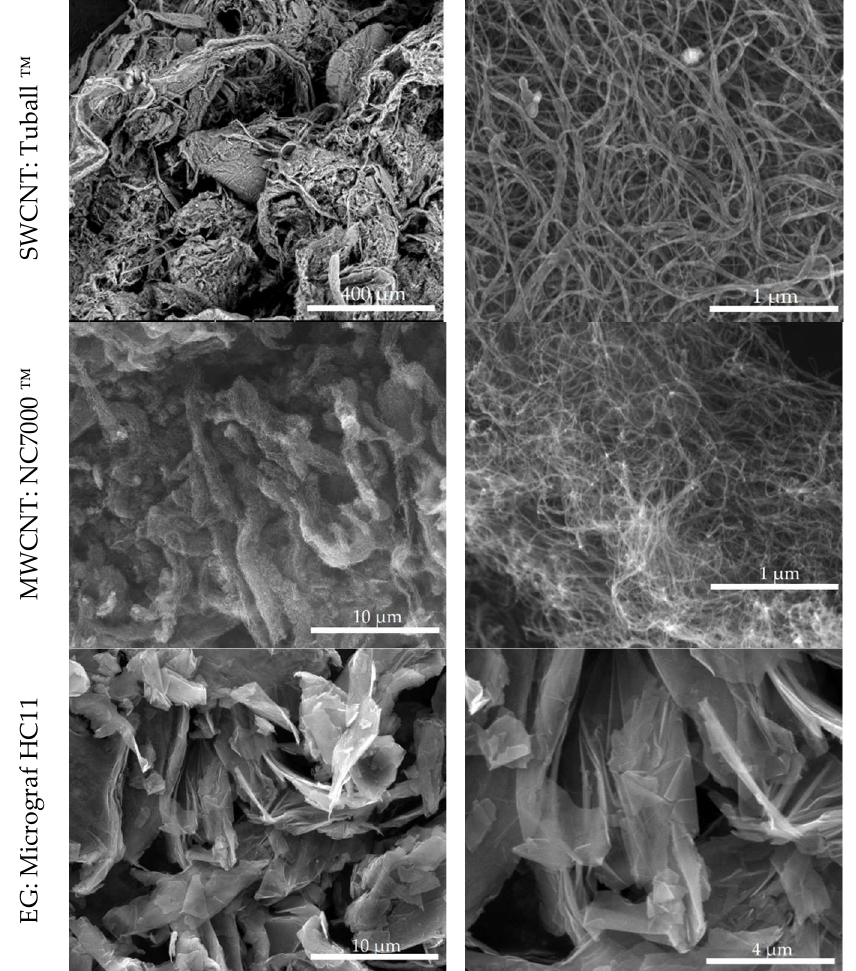
Figure 3. SEM micrographs of the selected carbon nanomaterials.